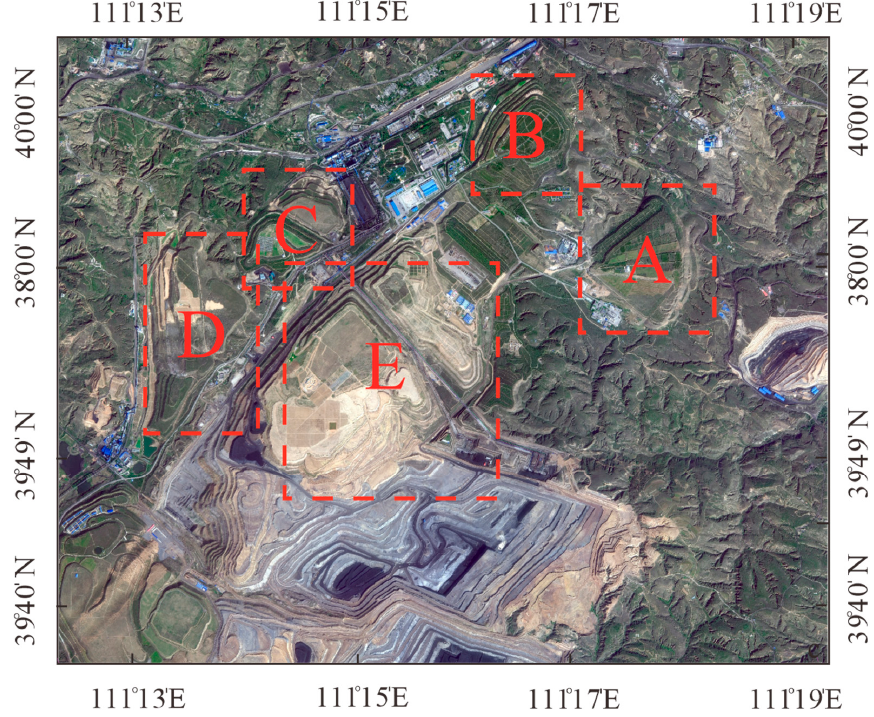
Figure 11. The location of each waste